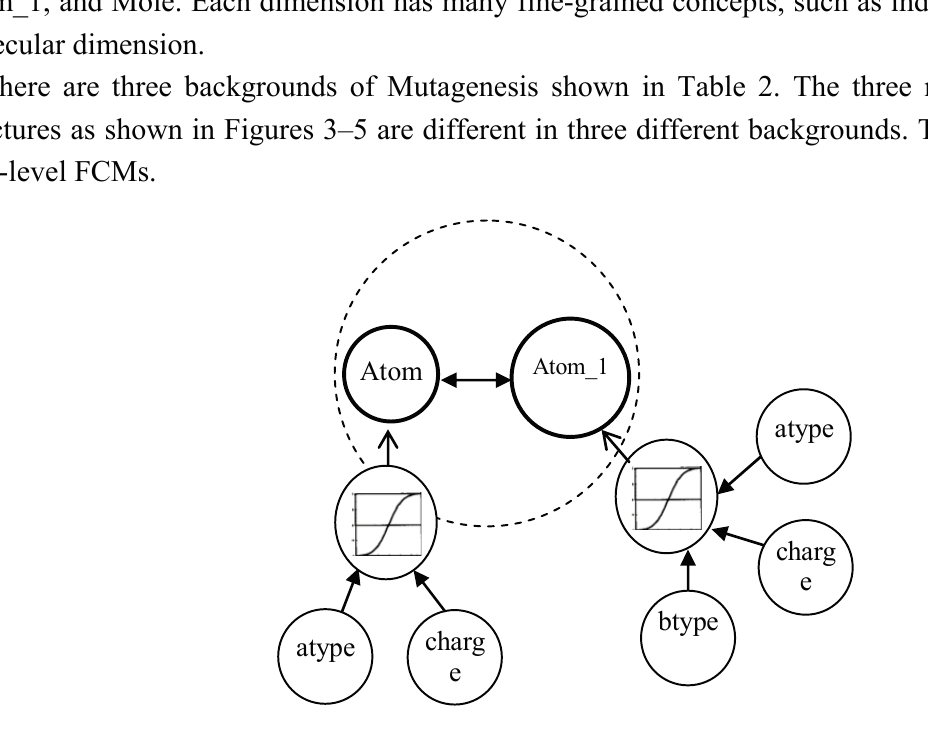
Figure 3. FCM structure of Mutagenesis in BK 0 .